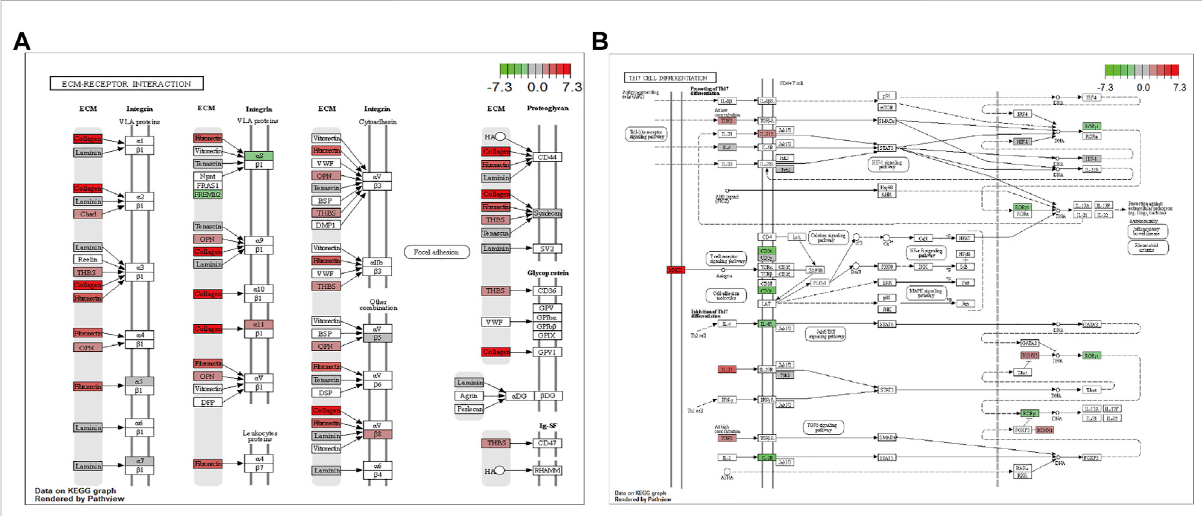
FIGURE 5 Visualization of the enriched KEGG pathways. (A) ECM-receptor interaction. (B) Th17 cell differentiation pathway. Each node indicates a gene that plays an important role in the pathway, and the color of the node is related to the log2FC value; green indicates downregulated genes, and red indicates upregulated